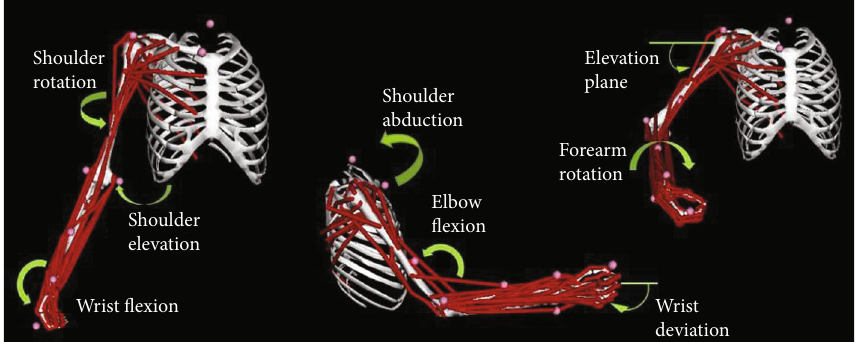
Figure 8: Dynamic musculoskeletal model of the upper limb. The dynamic model incorporates 7 degrees of freedom, including shoulder rotation and elevation and wrist fl exion, wrist deviation and elbow fl exion, and elevation plane of the shoulder and forearm rotation.